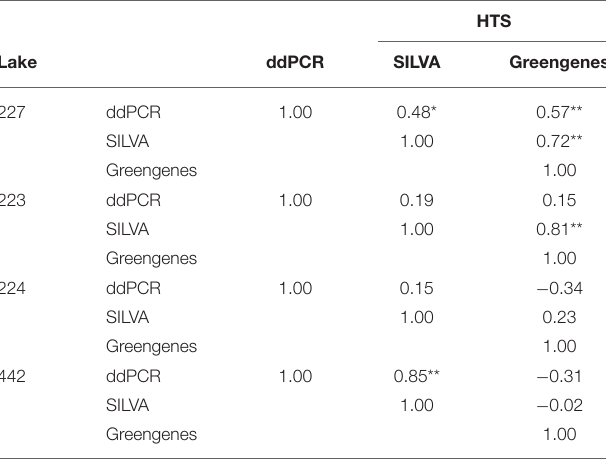
TABLE 3 | Kendall’s (L227) and Pearson’s (L223, L224, and L442) correlation coefficients of arcsine square root transformed relative Microcystis abundances derived from droplet digital PCR (ddPCR) and from high-throughput sequencing (HTS), using the SILVA and Greengenes